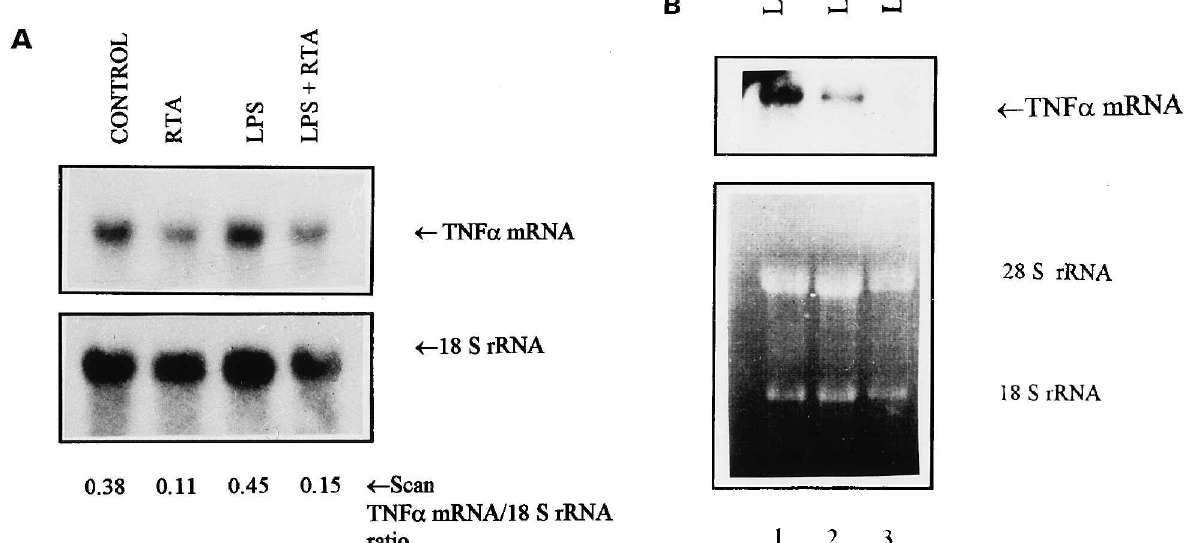
FIG. 1. (A and B) Effect of RTA (10 m M) and/or LPS (500ng/ml) on relative TNF a mRNA abundance in unprimed* (B, lane 3) U937 cells or in the cells primed for 48h with PMA (34 ng/ml) and exposed for 1h to RTA and for the next 2h to LPS. For comparison blots were rehybridized with a probe for 18 S RNA (A) or UV picture of 18S and 28S rRNA in the ethidium bromide-stained gel is shown (B). For further detail see Materials and Methods. In order to account for differences in RNA load of the gel the ratios of densitometric scans of TNF- a mRNA to 18 S rRNA are reported